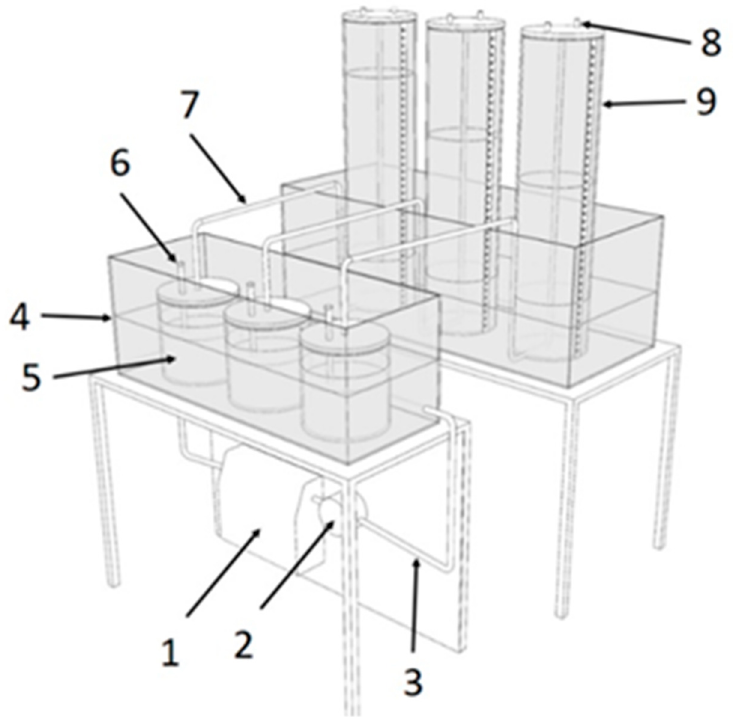
Figure 1. Scheme of research biofermenter for biogas production (three-chamber section): 1—water heater with temperature regulator, 2—water pump, 3—insulated conductors of calefaction liquid, 4—water coat, 5—fermenter with charge capacity 2 dm 3 , 6—sampling tubes, 7—biogas transporting tube, 8—gas sampling valve and 9—biogas volume-scale reservoir [30].